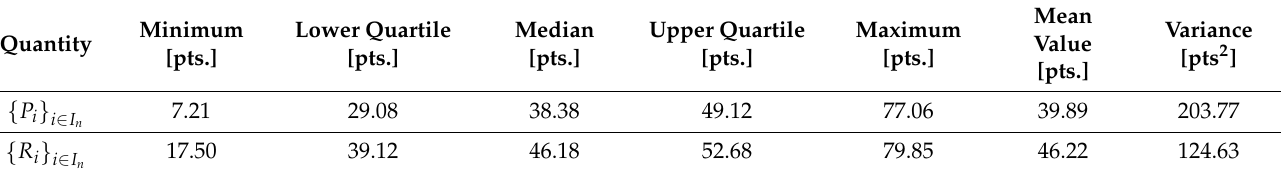
and { R i } . i ∈ I n i ∈ I n